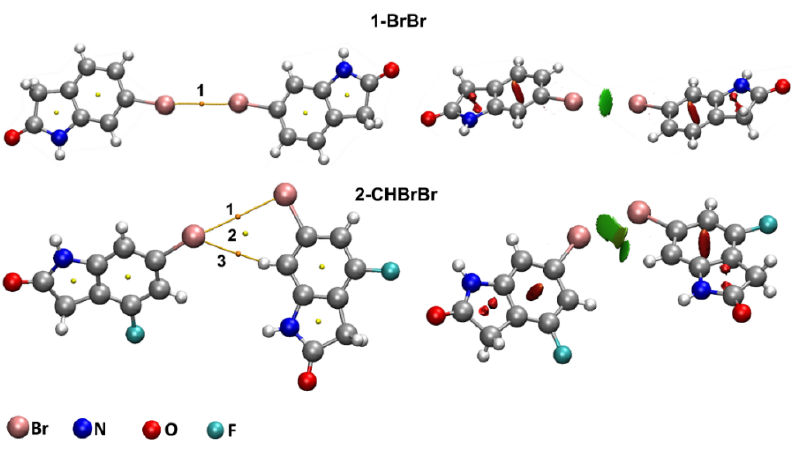
Figure 4. Critical points and RDG isosurfaces for 1-BrBr and 2-CHBrBr dimers obtained with the MP2/def2-TZVP theory level. The orange points indicate bond critical points (BCP), yellow points indicate ring critical points (RCP) and yellow lines indicate the bond paths. The RDG isosurfaces where obtained with isovalues of 0.65 a.u. The green-colored region indicates a van der Waals interaction in the Br ··· Br contact regions. A BCP for C-H···Br contact was also observed in 2-CHBrBr and 1-CHOCHBr com- plexes. As shown in Tables 3 and S1, this BCP also presented QTAIM parameters very similar to those observed for Br···Br contacts, which indicates a vdW attractive interaction.